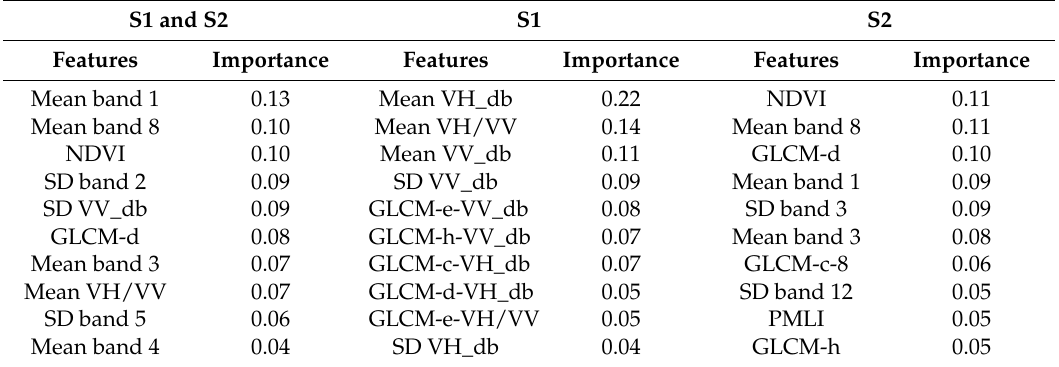
Table 4. Feature importance in CART using different band combinations. (SD: Standard deviation).